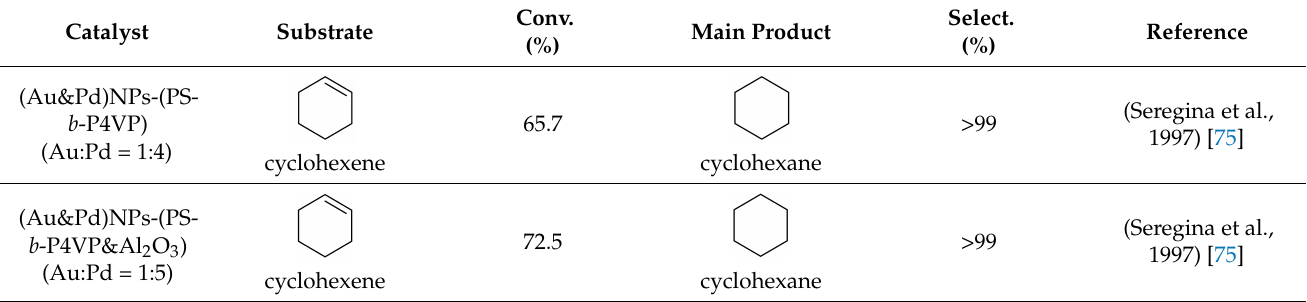
Table 1. Hydrogenation of C-C unsaturated bond catalyzed by AuNPs and dihydrogen.